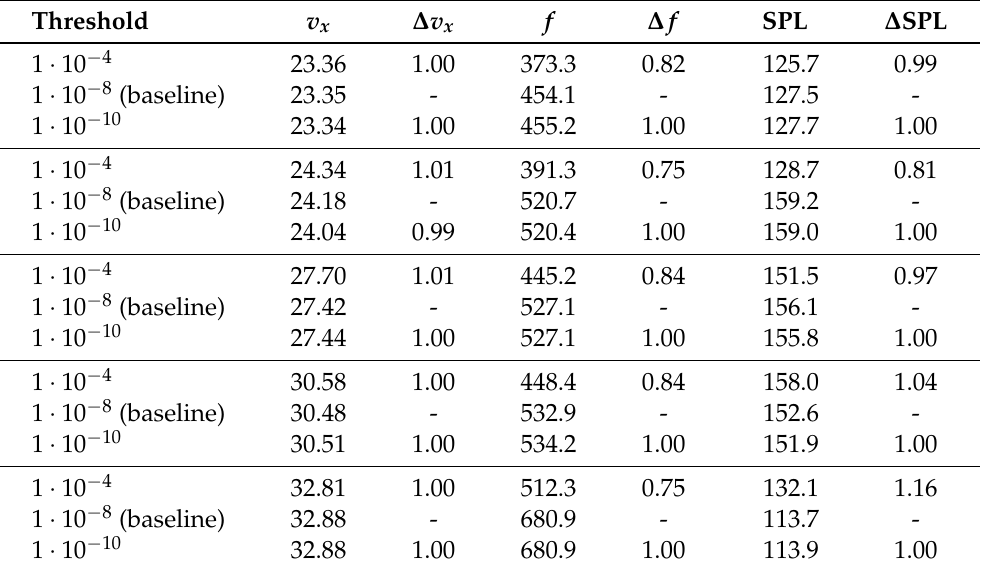
Table 5. Influence of termination threshold for the pseudo time solver on velocity, shedding frequency, and sound pressure level.